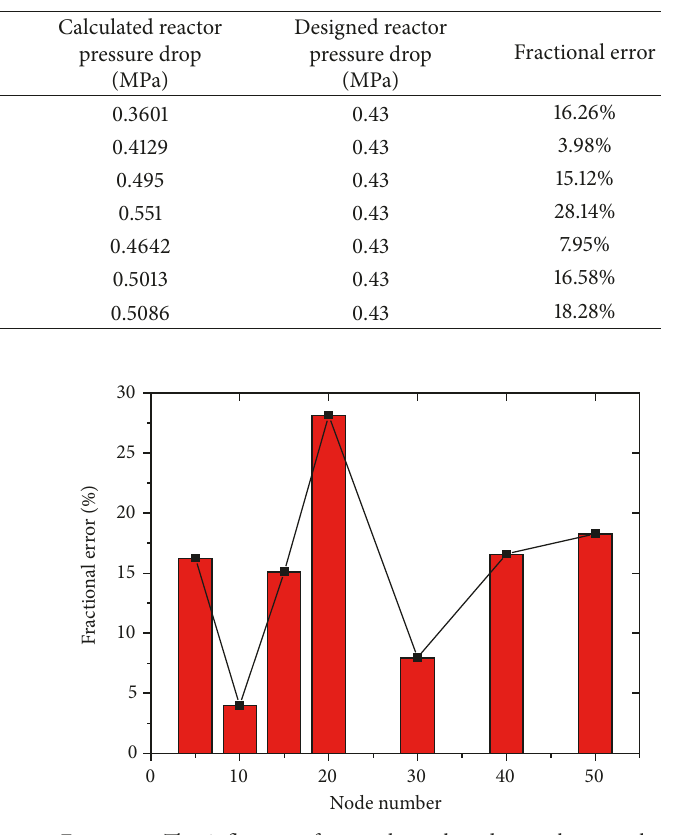
Figure 5: The influence of core channel node number on the fractional error between calculated and designed reactor pressure